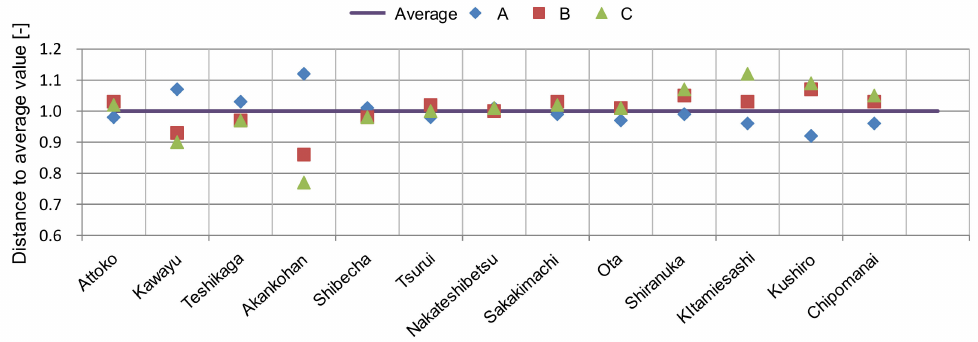
Figure 11. Distance between the climate element and the average value of each region (example). Table 15. Example of selecting representative points for each climate. Solar-Heat Heating Daily Solar Global Available A Distance from Average Value (Dt) Degree Horizontal Days Day Irradiance